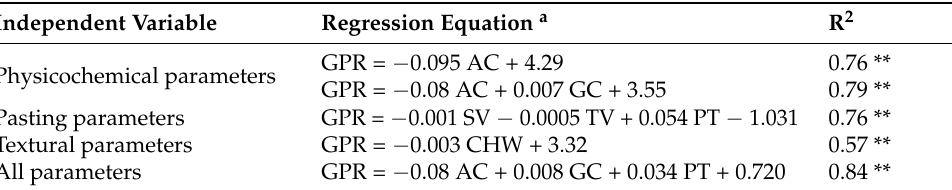
Table 3. The stepwise multiple regression analysis of physicochemical, pasting and textural parame- ters to GPR.